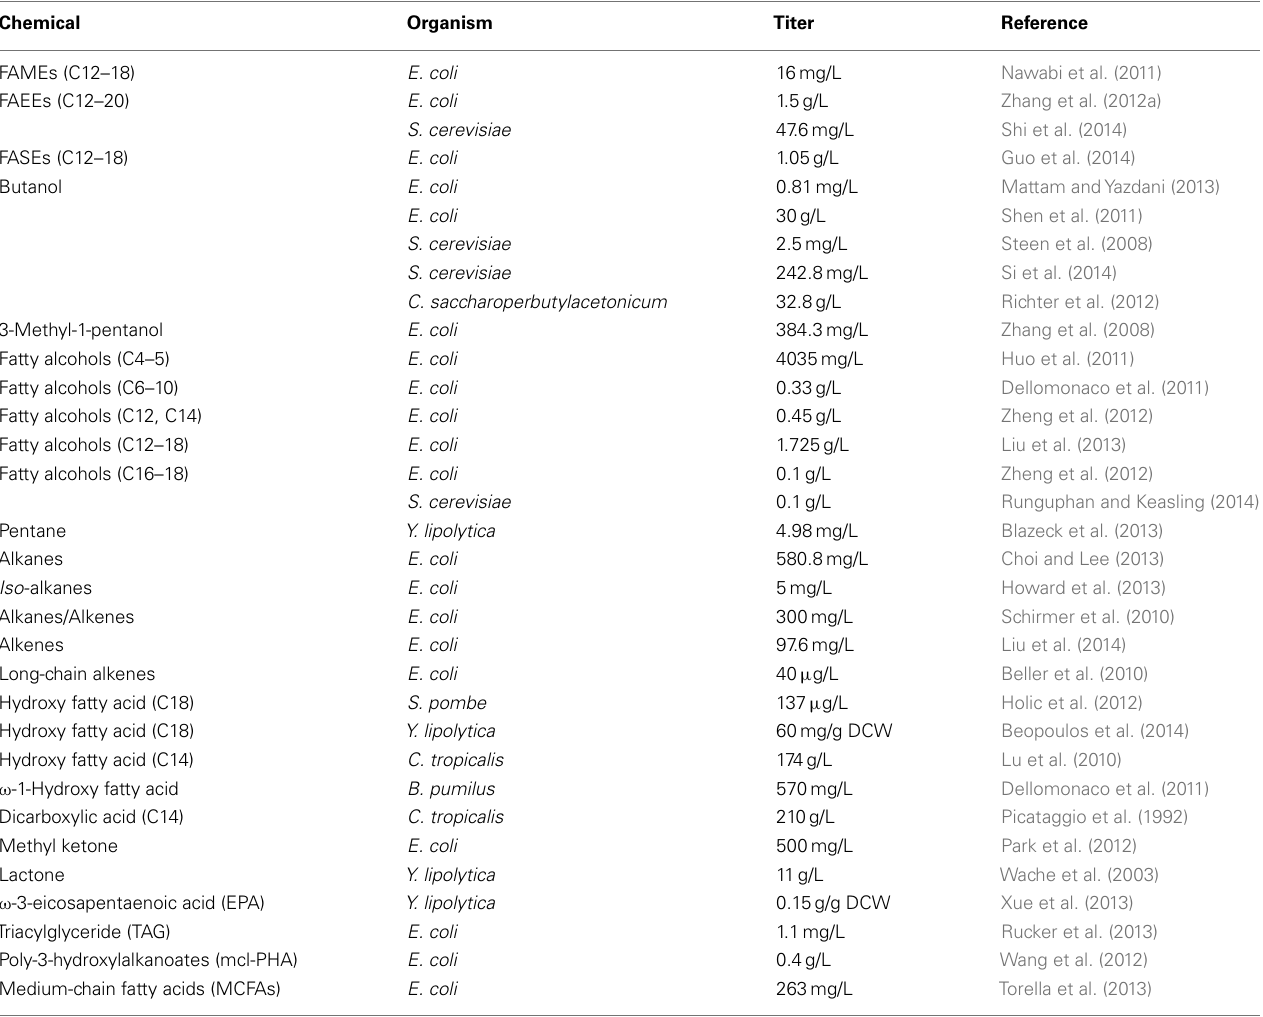
Table 1 | Examples of valuable fatty acid-derived chemicals produced by metabolically engineered microorganisms